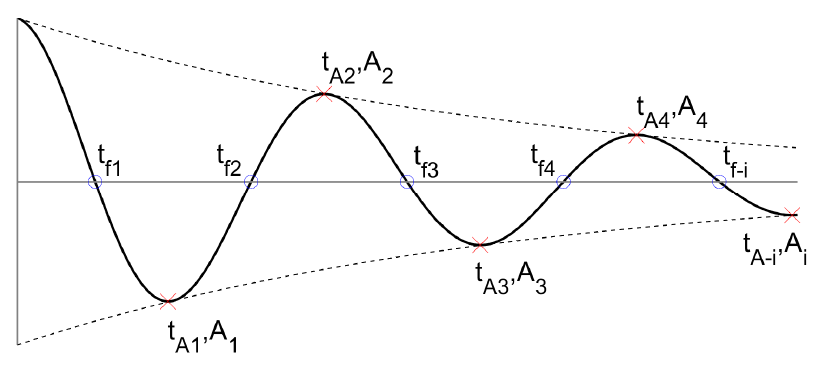
Figure 2. A typical response of an underdamped system.